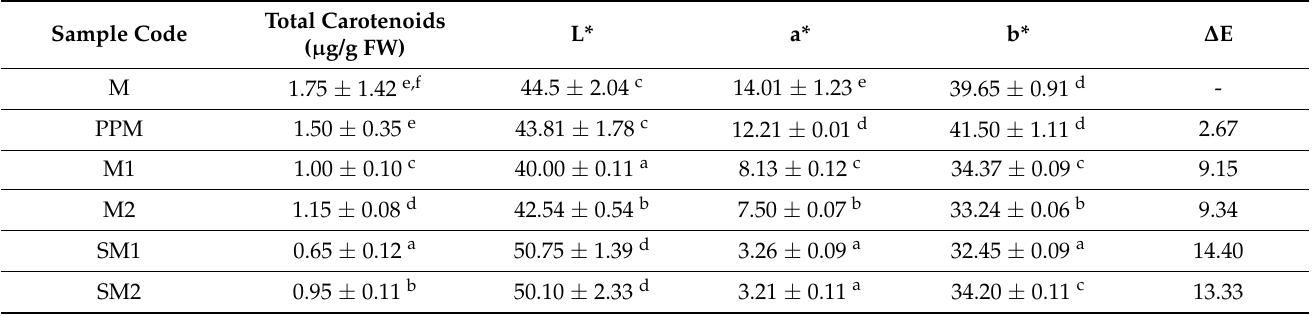
Table 7. Changes in total carotenoids content (on fresh weight of tissue -FW) and color values (L* a* b*) in investigated pumpkin pulps and probiotic frozen desserts (cultivar “ Miranda ” of the Cucurbita moschata